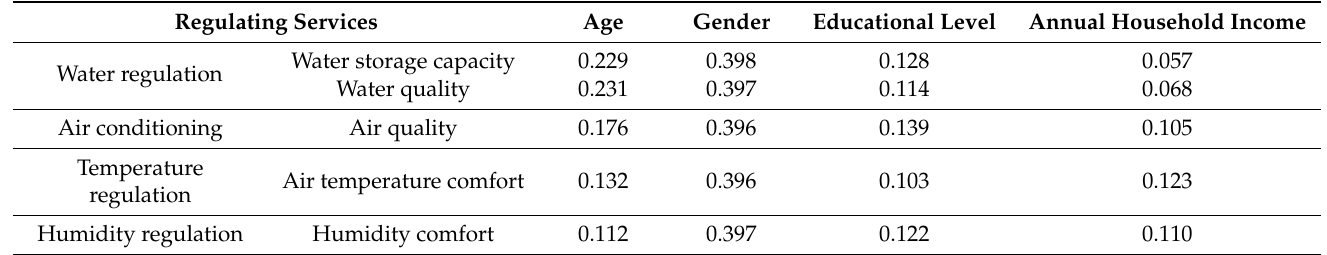
Table 11. Cramer’s V value of the correlation between perception of regulating service and individ- ual